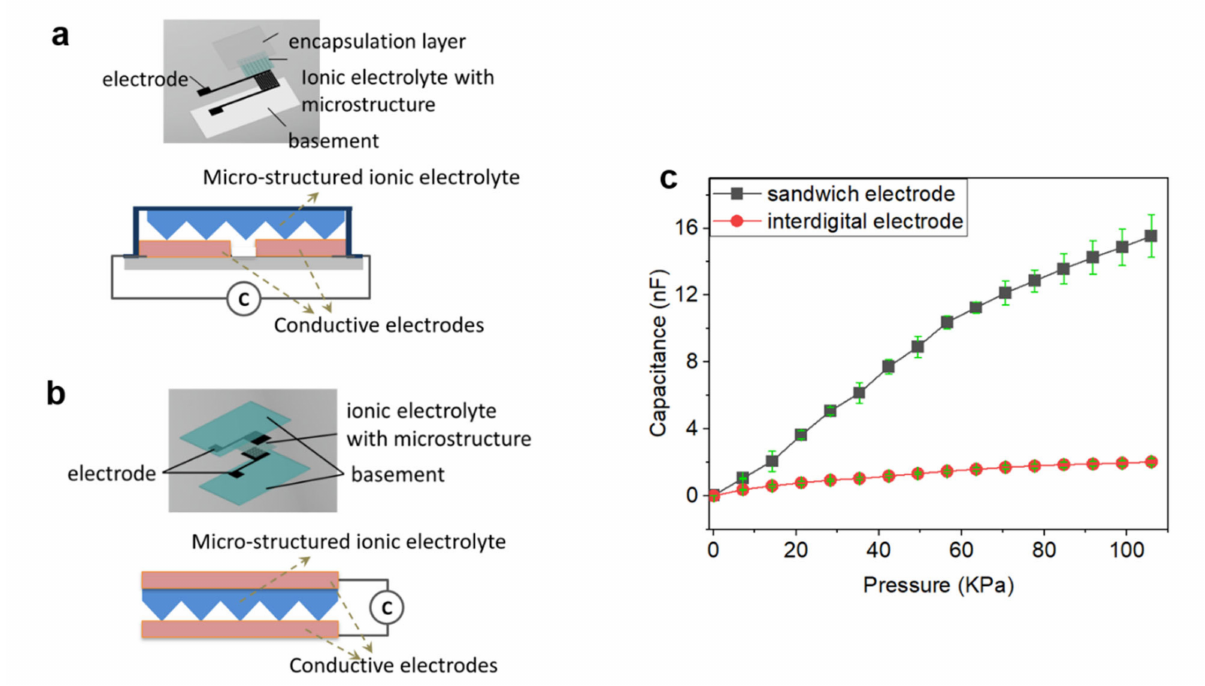
Figure 3. Iontronic pressure sensors with different device configurations. ( a , b ) The basic structure, components, and measurement of pressure sensors with different configurations: interdigital elec- trode configuration ( a ) and sandwich electrode structure ( b ). ( c ) Response behaviors of the pressure sensors with different device